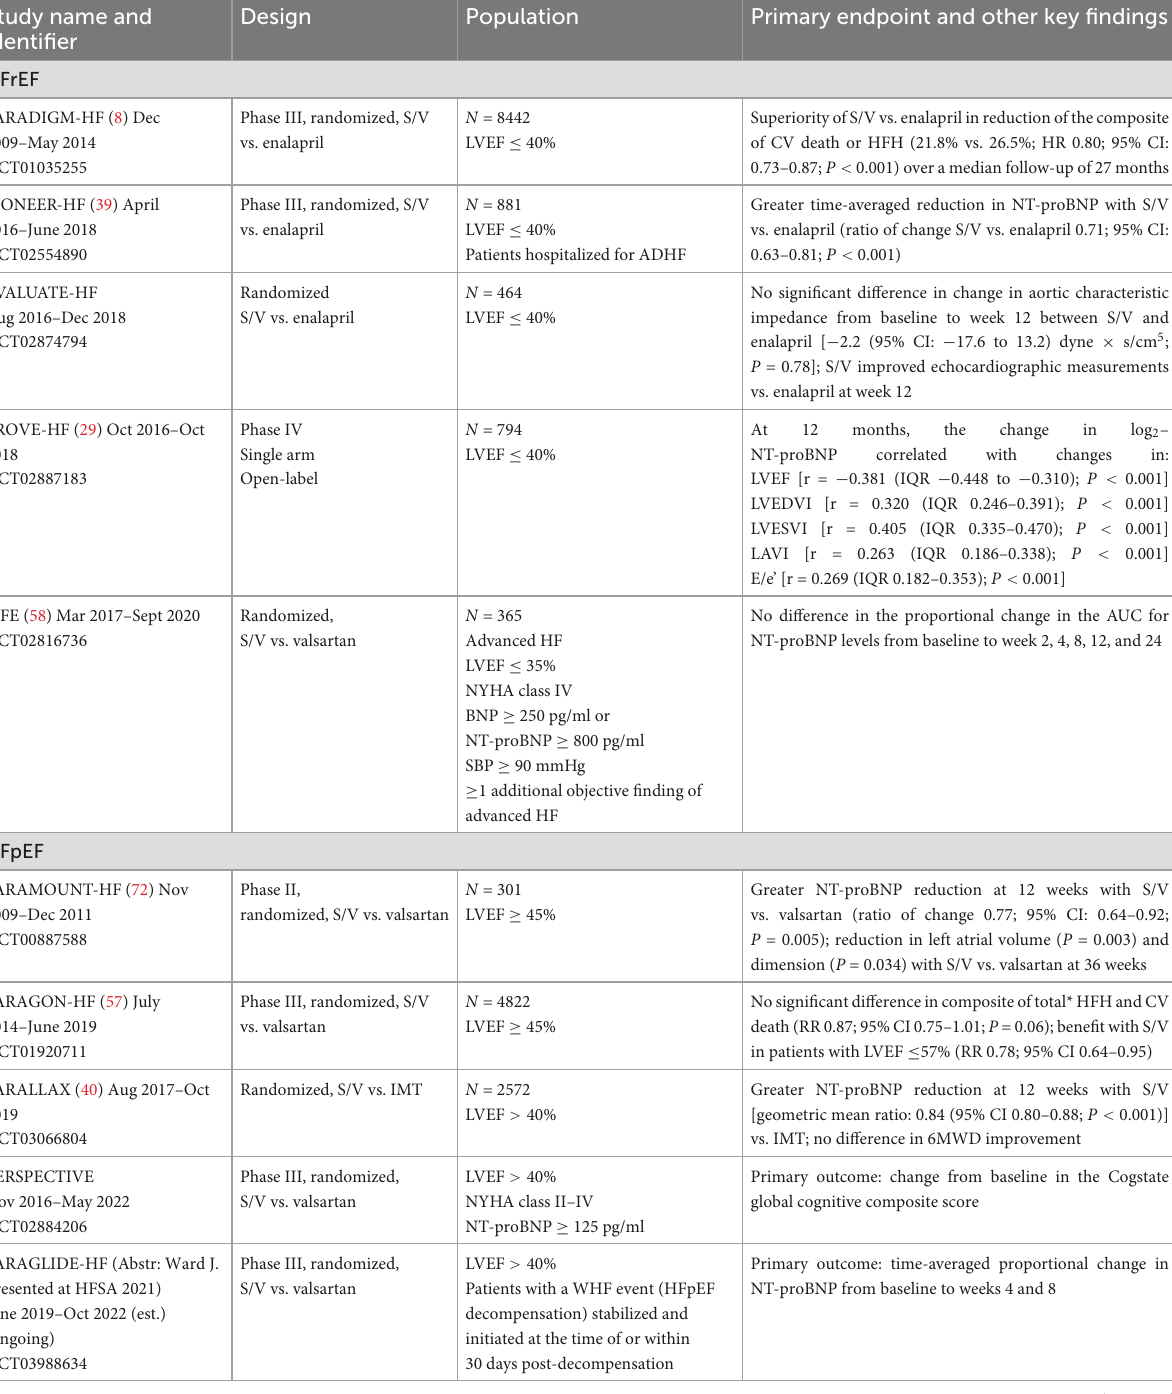
TABLE 2 Key clinical trials investigating the effects of